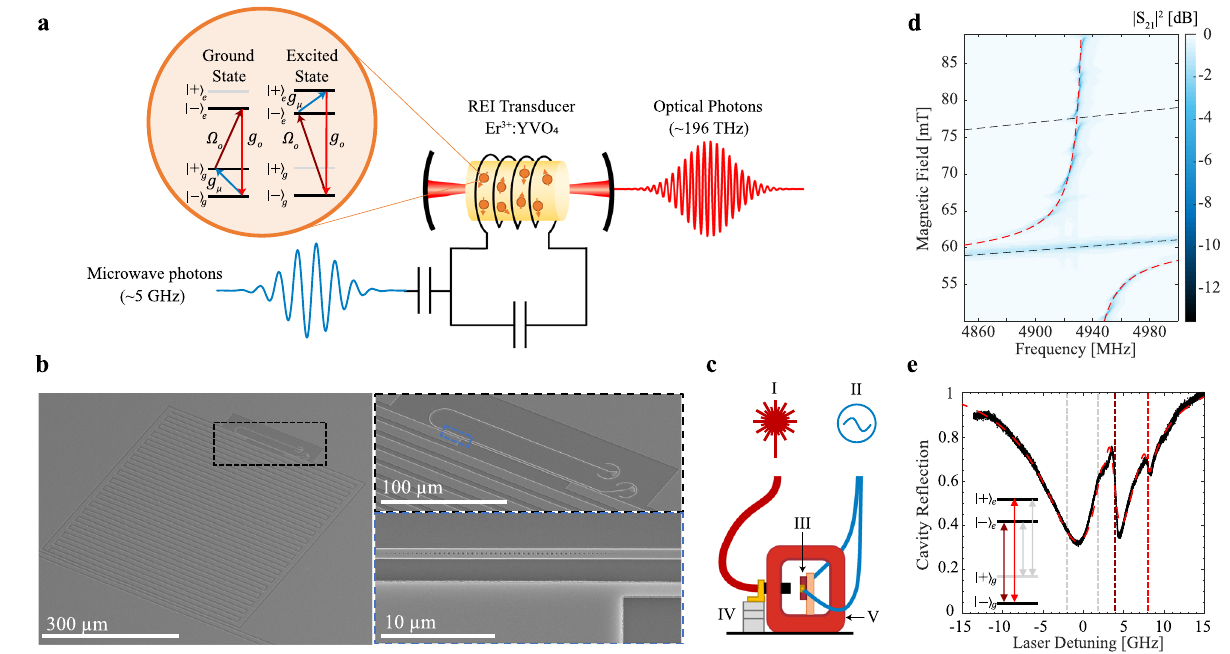
Fig. 1 | Integrated rare-earth ion transducer and ion-cavity coupling char- acterization. a Schematic of the rare-earth ion transducer using Er 3+ :YVO 4 . The erbium ions simultaneously couple to an optical cavity and a superconducting microwave cavity. Microwave photons can couple to either the ground state or excited state spin transitions (g μ ), while optical photons can couple to four dif- ferent opticaltransitions ( Ω o for the pump and g o for the output photon).The two levels in the ground state are labeled ∣ (cid:1)i g & ∣ + i g and the two levels in the excited statearelabeled ∣ (cid:1)i e & ∣ + i e ,wherethe+,-correspondstothesignofthecrystal fi eld quantum number of the states. Transduction is achieved by mixing a microwave photon with an optical pump fi eld and generating an optical photon, where each light fi eld couples to an erbium transition. b SEM images of the rare-earth ion transducer. The full device including the microwave resonator and optical reso- nator on the Er 3+ :YVO 4 substrate are shown on the left, while the zoomed images show a close up of the optical resonator next to the inductive wire and a photonic crystal mirror, respectively. c Schematic of the transducer characterization set-up